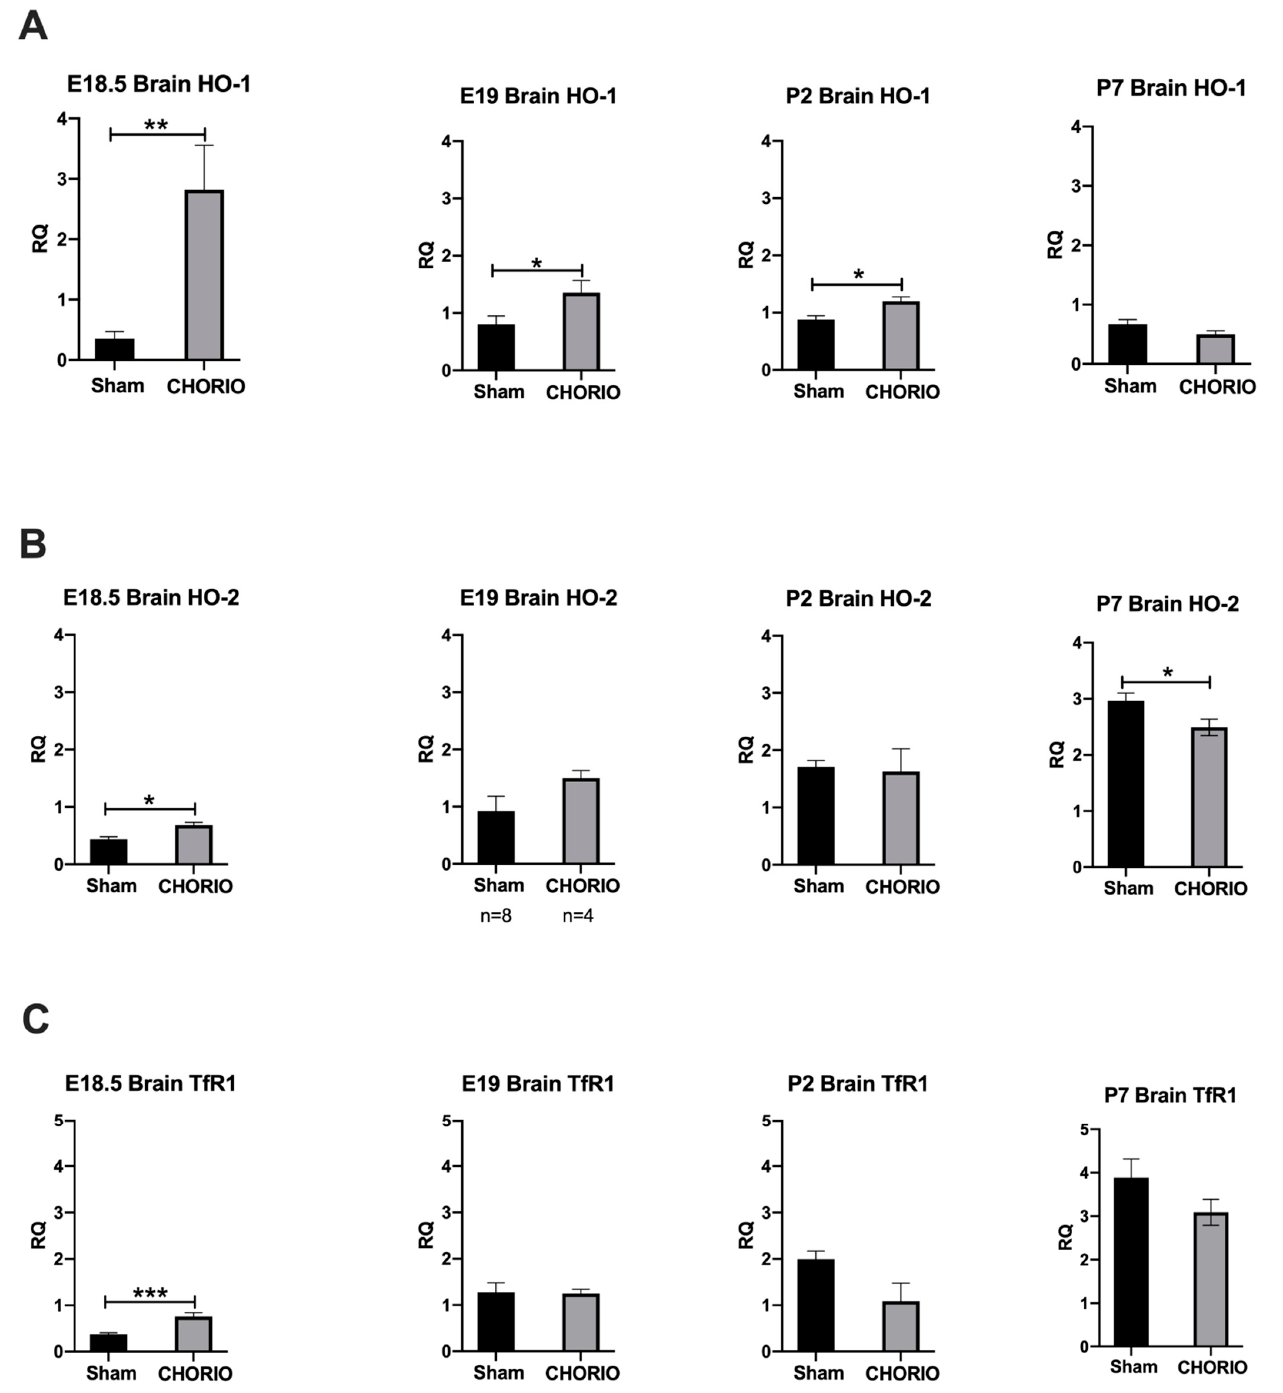
Figure 4. CHORIO alters HO-1, HO-2, and TfR1 expressions in brain compared to Sham. At E18.5, CHORIO upregulated HO-1, ** p = 0.0061 ( A ), HO-2, * p = 0.0152 ( B ), and TfR1, *** p = 0.0006 ( C ) in brains compared with sham. At E19 and P2, CHORIO upregulated HO-1, * p = 0.0317 and * 0.0490, respectively ( A ) in brains compared with sham. At P7, CHORIO downregulated constitutional HO-2 expression, * p = 0.0175 ( B ) significantly compared with sham. p significant when < 0.05, Kruskal–Wallis test, mean ± SEM.